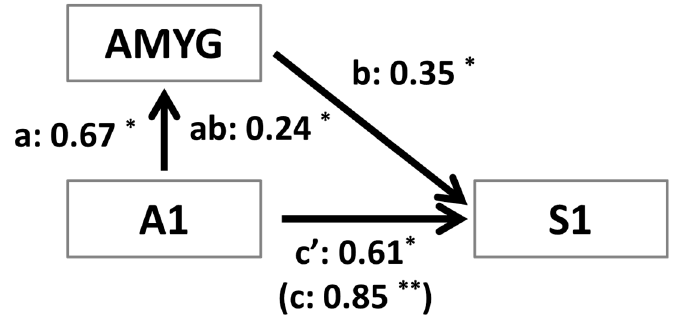
Figure 3. Mediation analysis at the group-level using the mean responses in each region per participant. For all variables ( i.e. , regions) in the network, signal differences between CS+ and CS − were used as the dependent measure. Path analysis was used to test the hypothesis that the initial effect of primary auditory reactivity (A1) on the response in the primary sensory cortex (S1) was mediated by reactivity of the amygdala (AMYG). As predicted, we observed a significant mediation effect ( i.e. , abs = 0.24), and the coefficient of the c’ 1 path ( i.e. , the effect of A1 on S1 after controlling for the amygdala as a mediator) was diminished yet still significant. The latter suggests A1 activity had an influence of S1 activity even after controlling for the amygdala mediation. * p < 0.05; ** p < 0.01